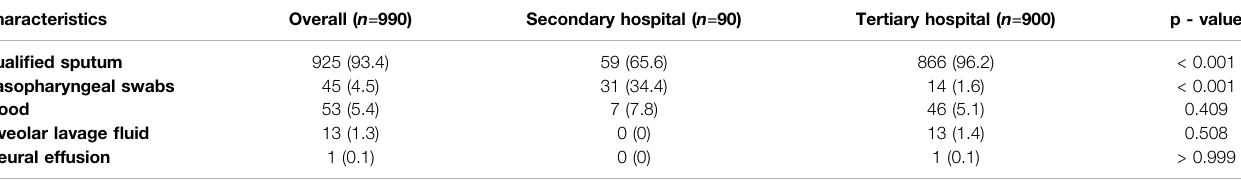
TABLE 4 | Specimen sources of included AECOPD patients receiving pathogen examinations. Characteristics